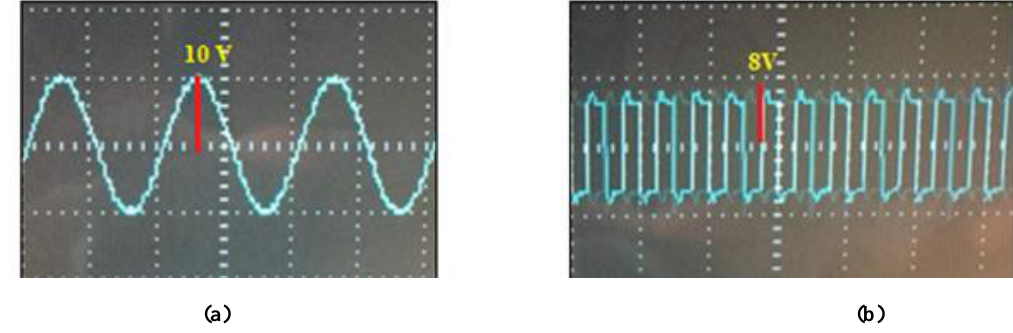
Figure 12: Output of the injection transformer when 12V pulse is injected from the neutral.